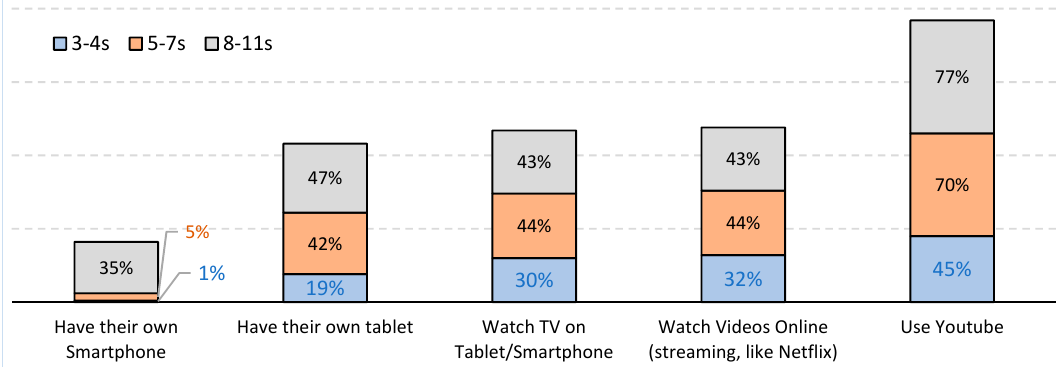
Figure 6. Device ownership and usage habits for the three classes of ages.